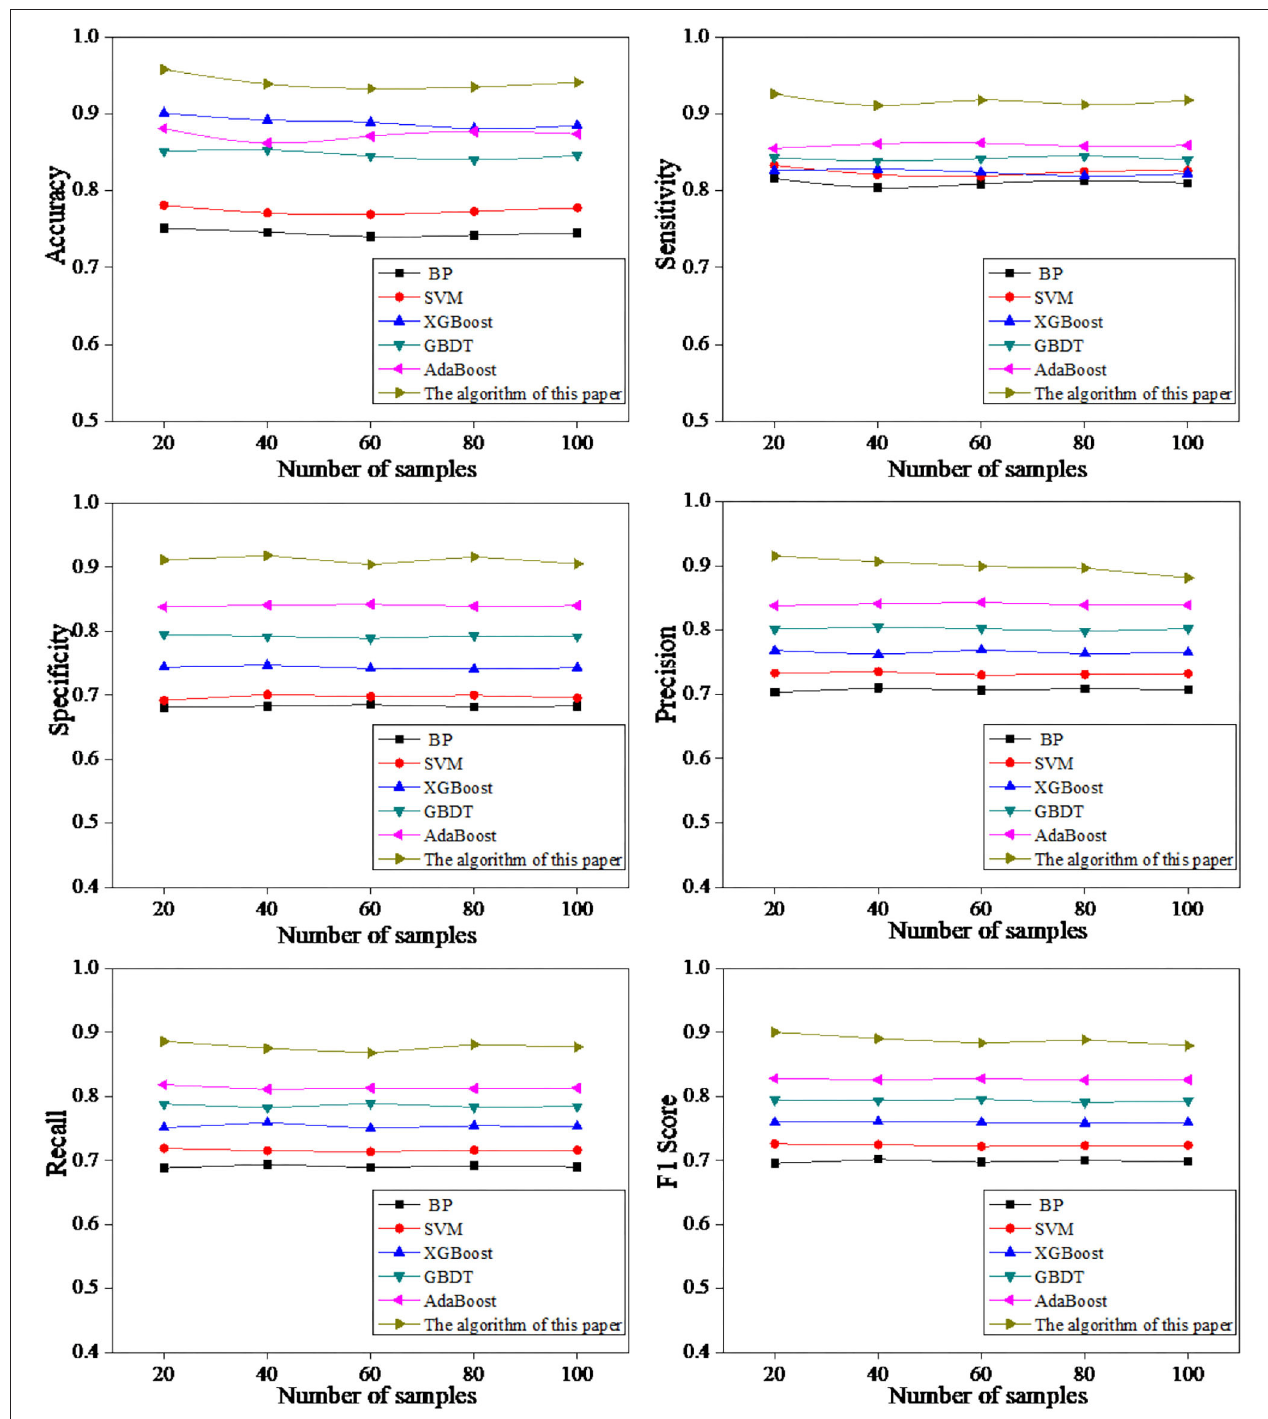
FIGURE 3 | Comparison of prediction effects based on different algorithms.